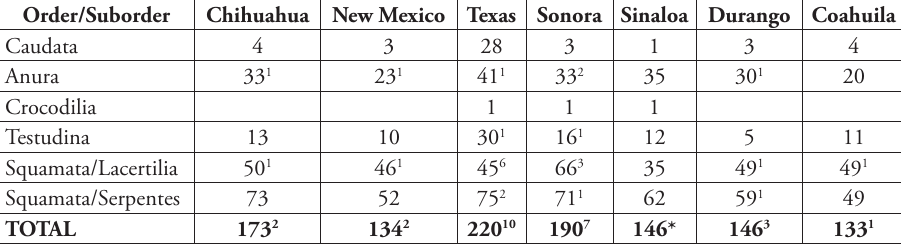
Table 3. Total number of native amphibian and reptile species in each state arranged according to taxo- nomic order/suborder. Superscripts indicate number of introduced species to the state.